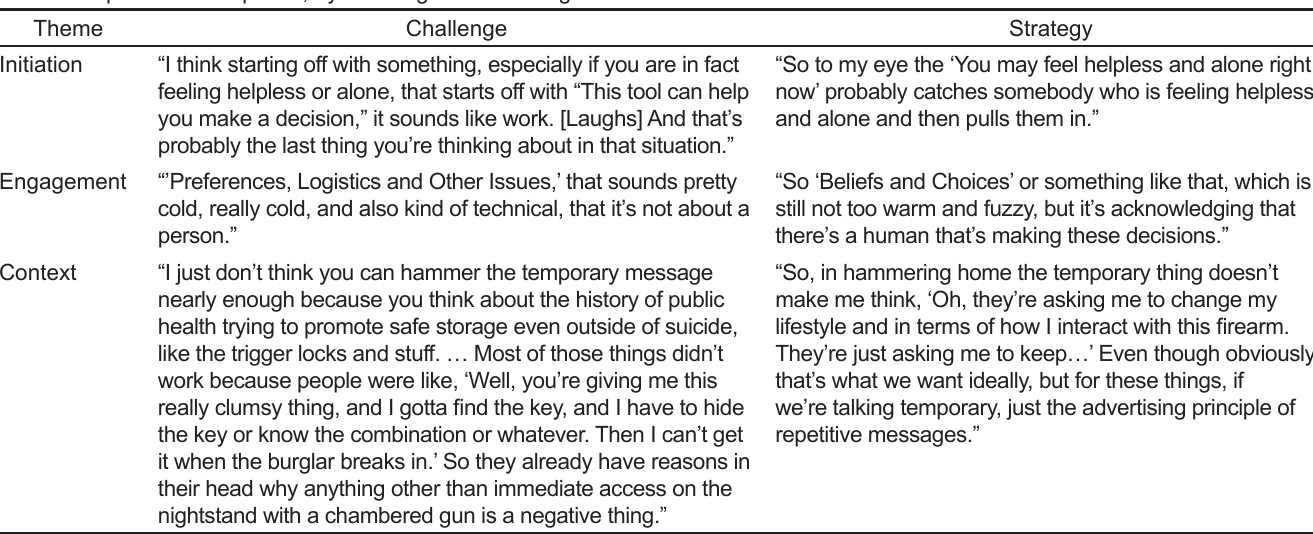
Table 2. Representative quotes, by challenges and